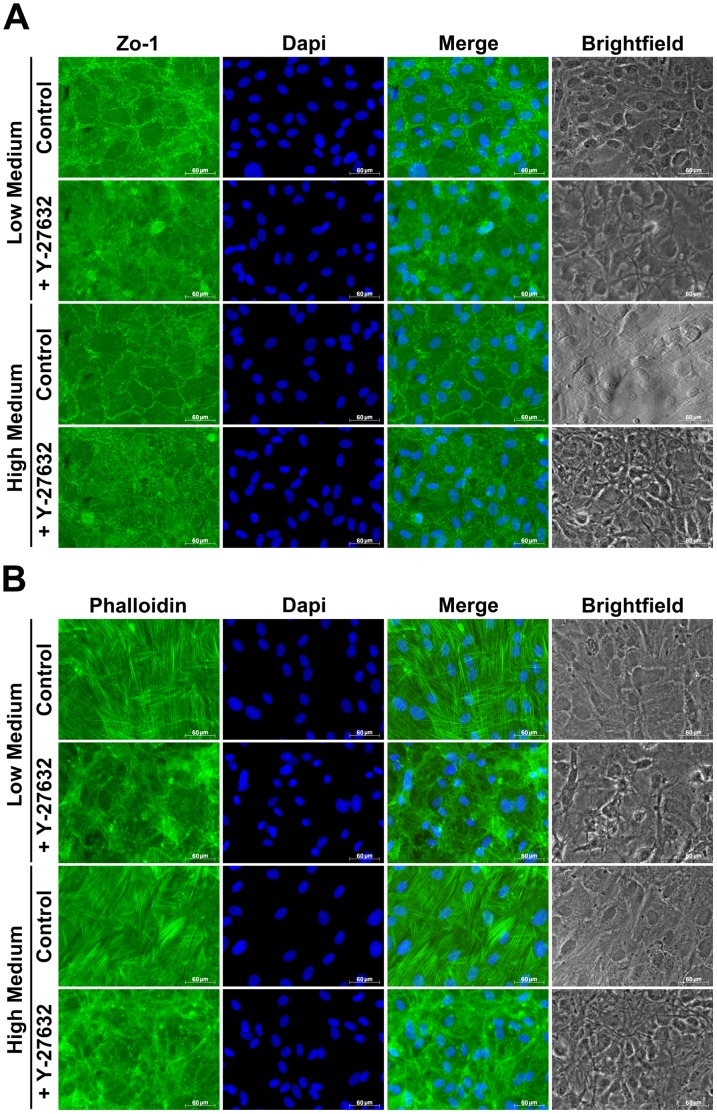

In vitro morphological assessment.(A) Zo-1 immunostaining reveals a continuous or partially segmented expression at intercellular junction in both conditions. This expression pattern is completely lost after Y-27632 addition in Low or High Medium culture with more diffuse intracellular staining. (B) Actin staining reveals radial and circumferential actin bundles in control groups. Y-27632 induces cytoskeleton reorganization, characterized by a redistribution of actin microfilament on the periphery of the cells and apparition of some membrane ruffles. (Magnification 40x) (n = 9).